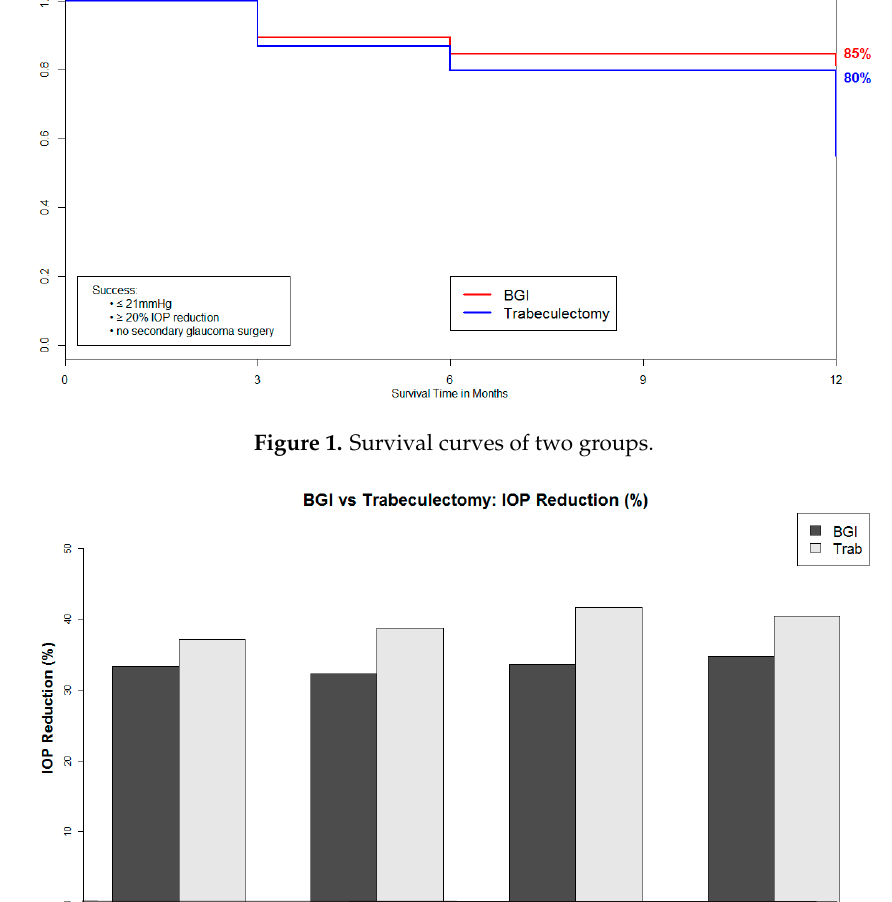
Figure 2. Percentage of IOP reduction.